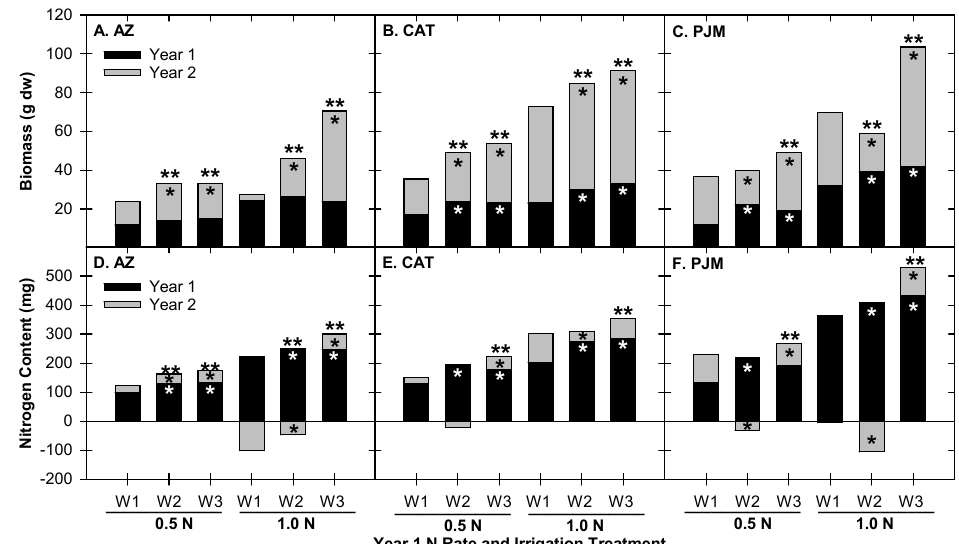
Figure 2. Total biomass (dry weight; dw) and N content of ‘Gibraltar’ (AZ) ( A , D ), ‘Catawbiense Album’ (CAT) ( B , E ), and ‘P.J.M.’ (PJM) Rhododendron ( C , F ). In Year 1, plants were grown in soilless media with N-free fertilizer (0 N) or N-free fertilizer plus 7 (0.5 N) or 14 (1.0 N) mg N per day from NH 4 NO 3 and irrigated once daily to 100% (W1) or 50% (W2) container capacity or twice daily to 100% container capacity (W3). In year 2, the plants were transplanted into soil. Segments within each column represent net biomass or N content in December of Year 1 and Year 2. Net biomass and N content within a year and N rate denoted by a single asterisk (*) are significantly different from W1 ( p < 0.05). Whole columns within an N rate denoted by two asterisks (**) are significantly different from W1 ( p < 0.05).